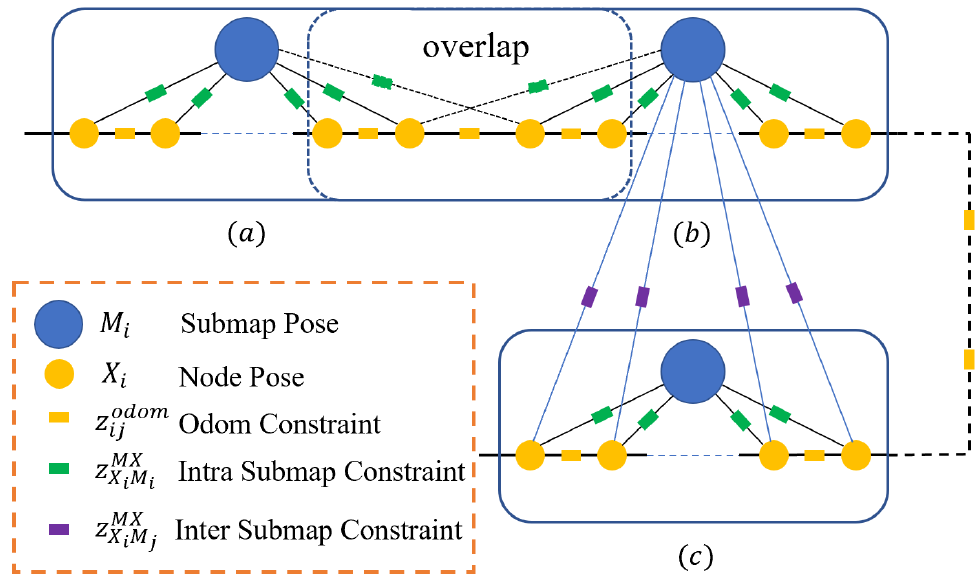
Figure 2. The system structure of constraint construction. ( a , b ) Two adjacent submaps, which are contacted by adjacent submap constraints, equivalent to odometry constraints actually. ( c ) A submap that triggers successful loop-closure detection on odometry, nodes of which can be matched with ( b ). The loop-closure constraint is called inter submap constraint in this system. In addition, inter submap constraint represents the transformation between the submap pose and node pose. The odom constraint represents the constraint between adjacent nodes on the